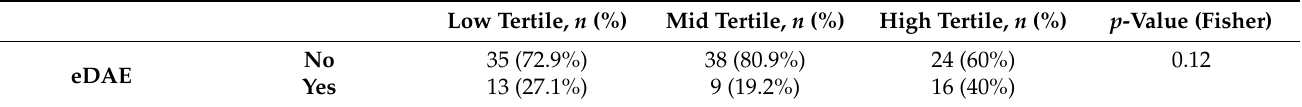
Table 5. Early dermatological adverse events (eDAE) in the three L-Gln groups.